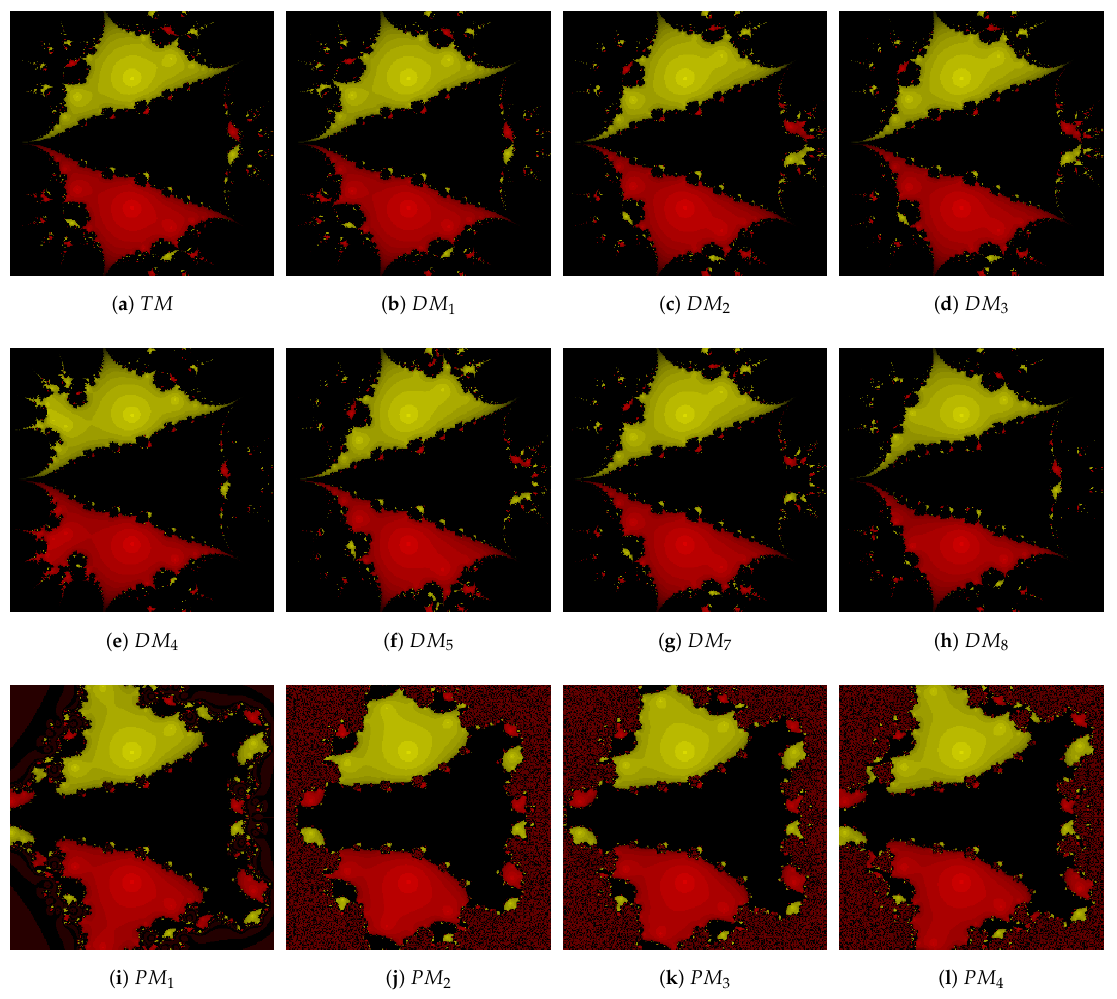
Figure 2. Comparisons of the convergence plane at β = − 0.01 for Problem 1.